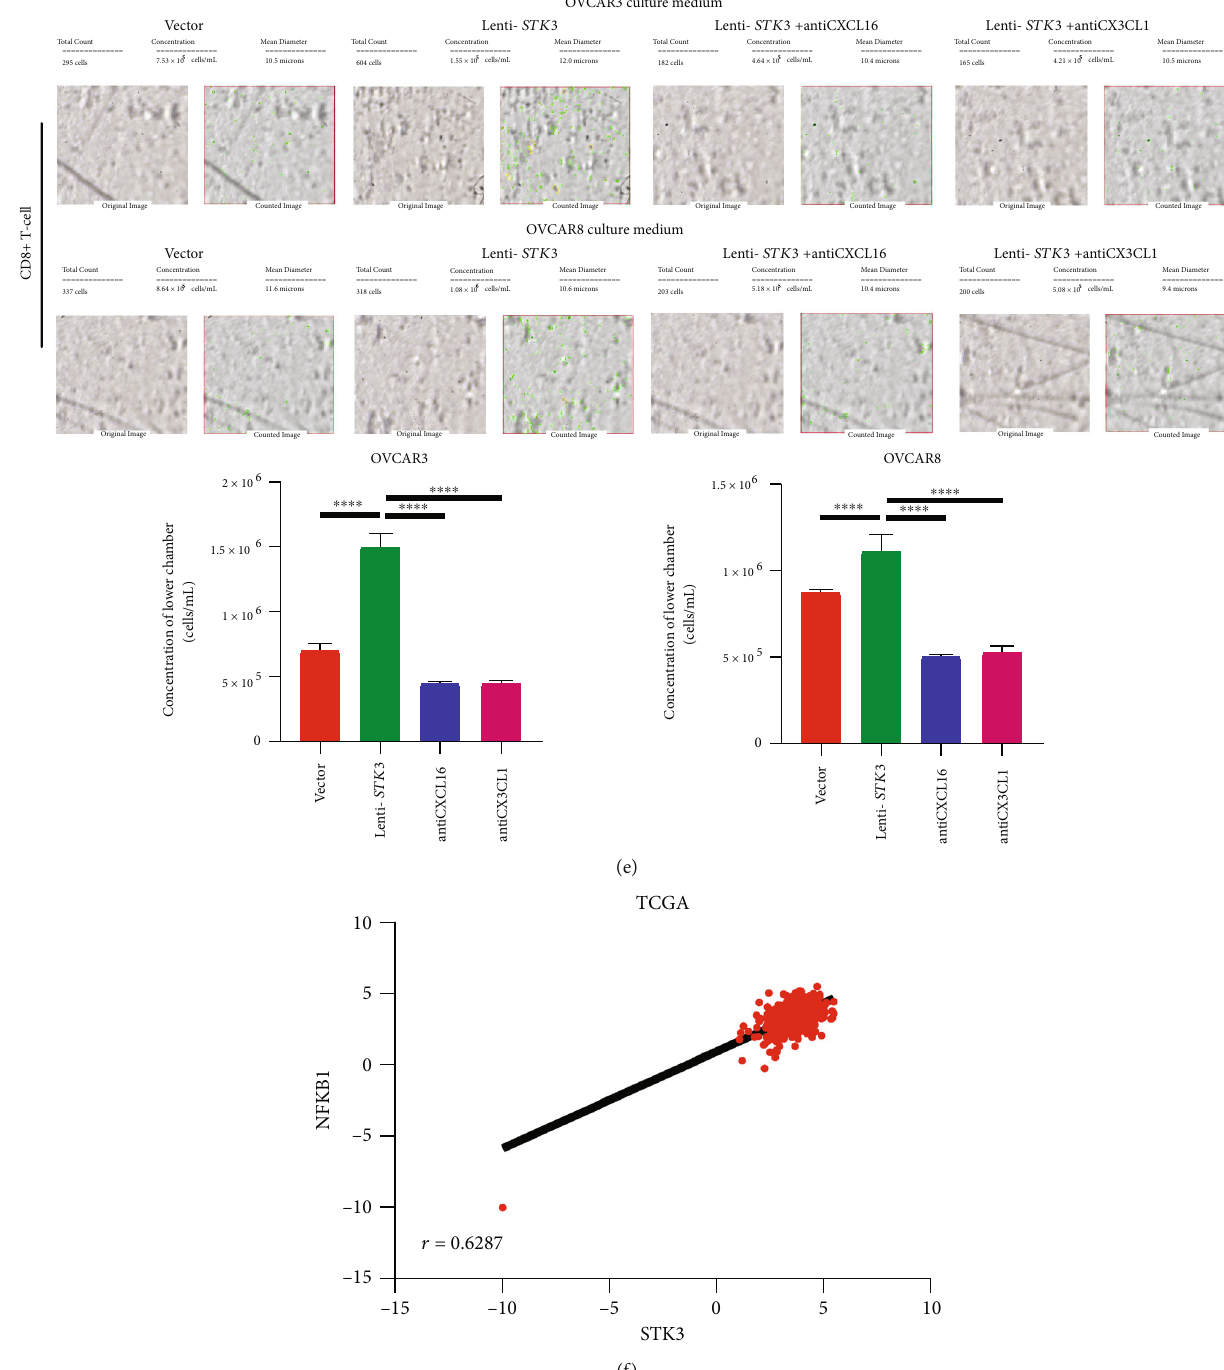
Total Count cells============== Concentration ============== Mean Diameter ============== 10.5 microns Total Count 295